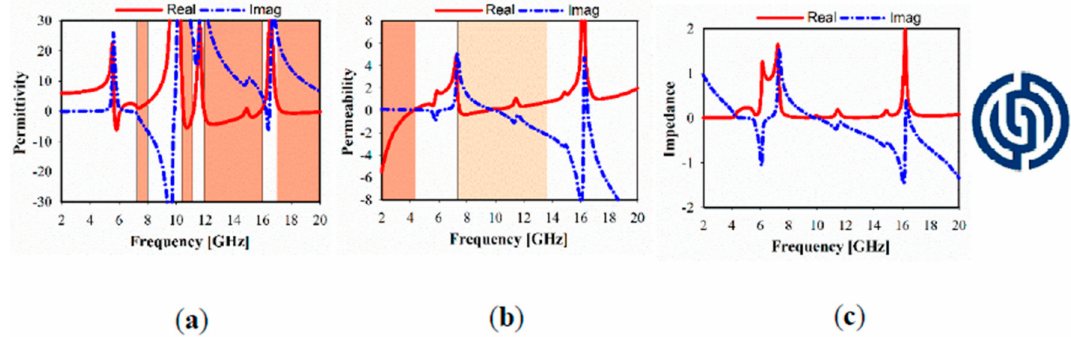
Figure 6. Metamaterial simulated result at y-axis: ( a ) permittivity; ( b ) permeability and ( c ) impedance.